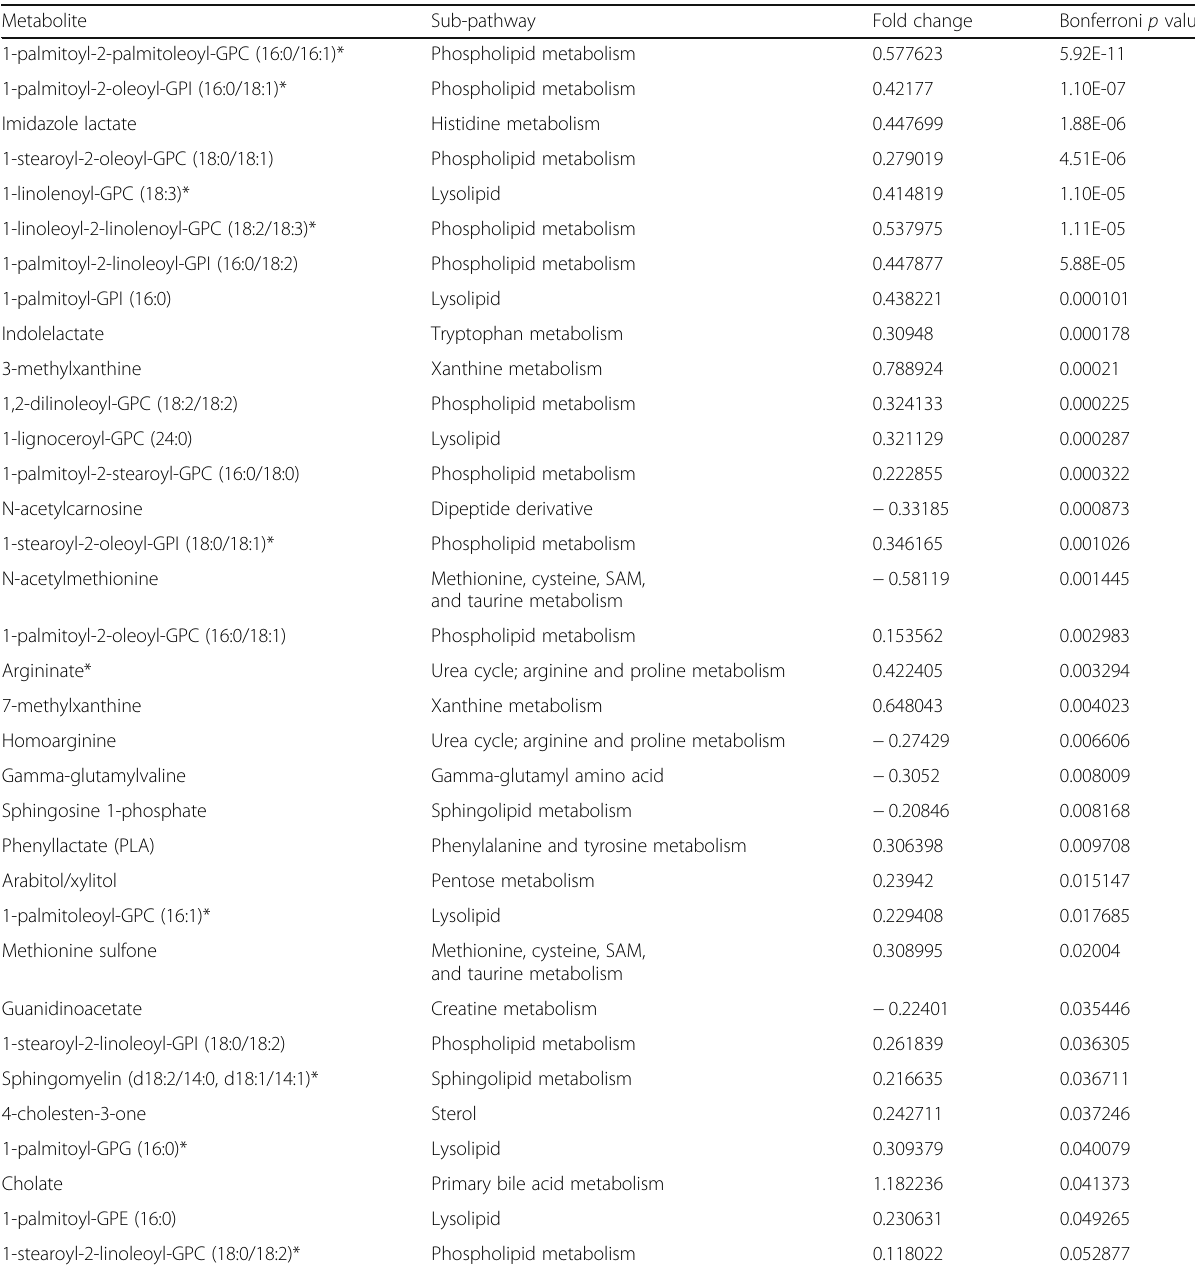
Table 3 Metabolites that differentiate moderate- versus high-power athletes Metabolite Sub-pathway Fold change Bonferroni p value